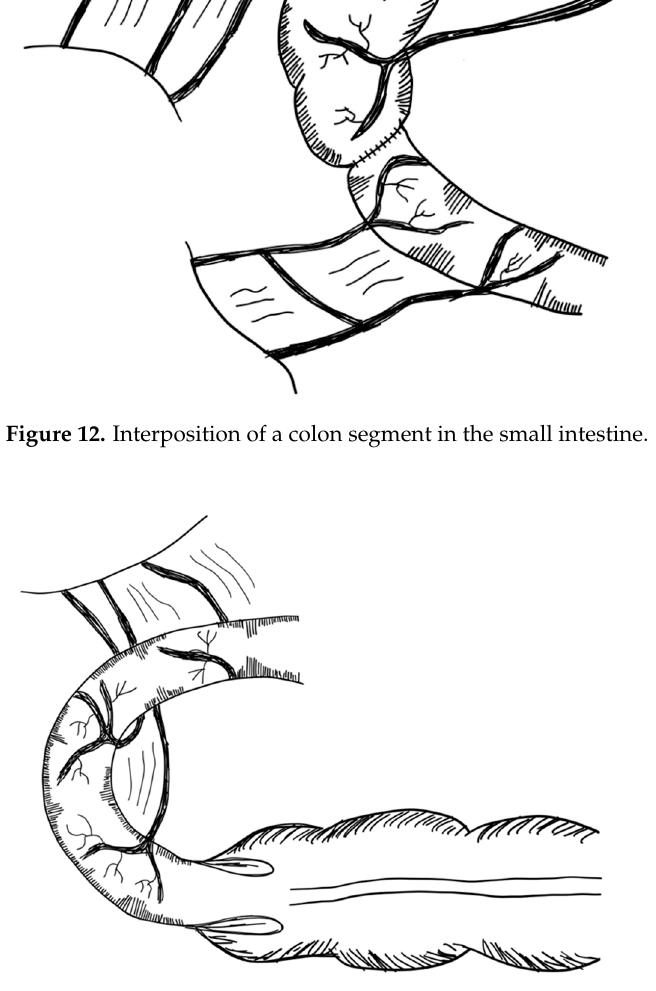
Figure 12. Interposition of a colon segment in the small intestine. Lloyd [160].